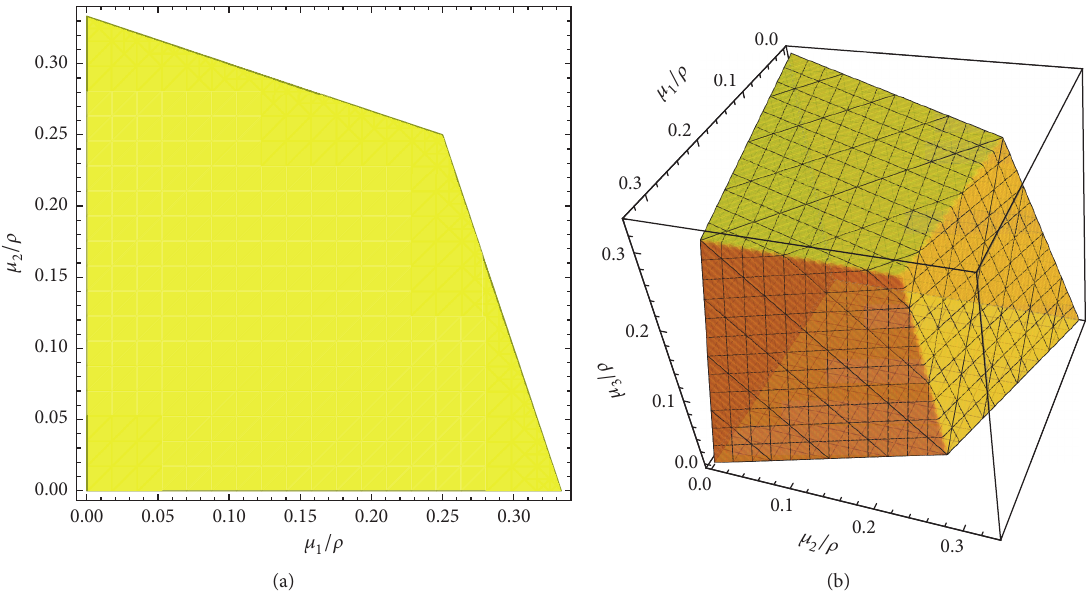
Figure 2: (a) Numerical reconstruction of D (𝜏 −1 𝜌 ) in V = 2 dimensions. (b) Numerical reconstruction of D (𝜏 −1 𝜌 ) in V = 3 dimensions.